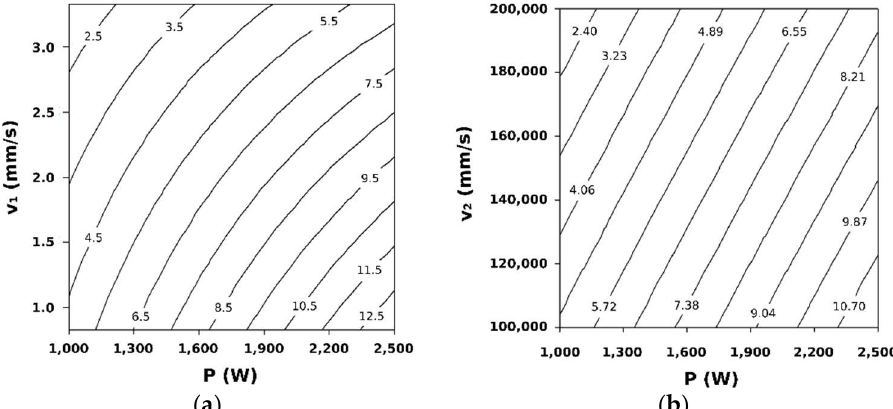
Figure 9. Contour plot of average roughness R a (μm) versus ( a ) laser power ( P ) and transverse speed ( v 1 ), and ( b ) laser power ( P ) and scanning speed ( v 2 ) during the processing of black granite.